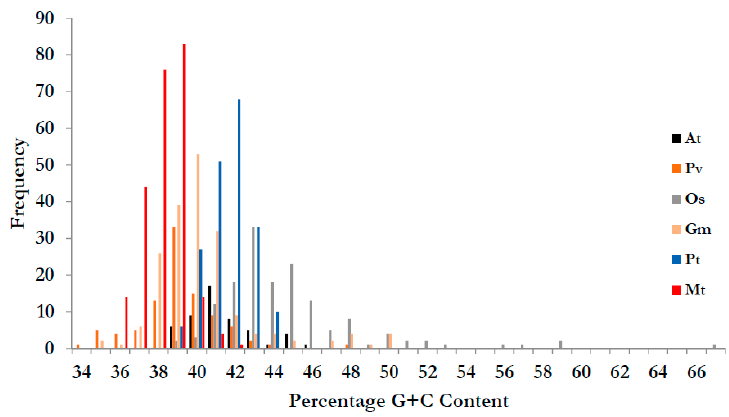
Figure 2. G+C content of the nTNL genes in non-legumes appeared higher than legume species. Rice nTNl genes had highest G+C content among the six species. Species are color-coded: legumes are in red-themed colors (Mt = red, Gm = pink and Pv = dark red) and non-legumes are in non-red colors (At = Black, Pt = Blue, Os = green).